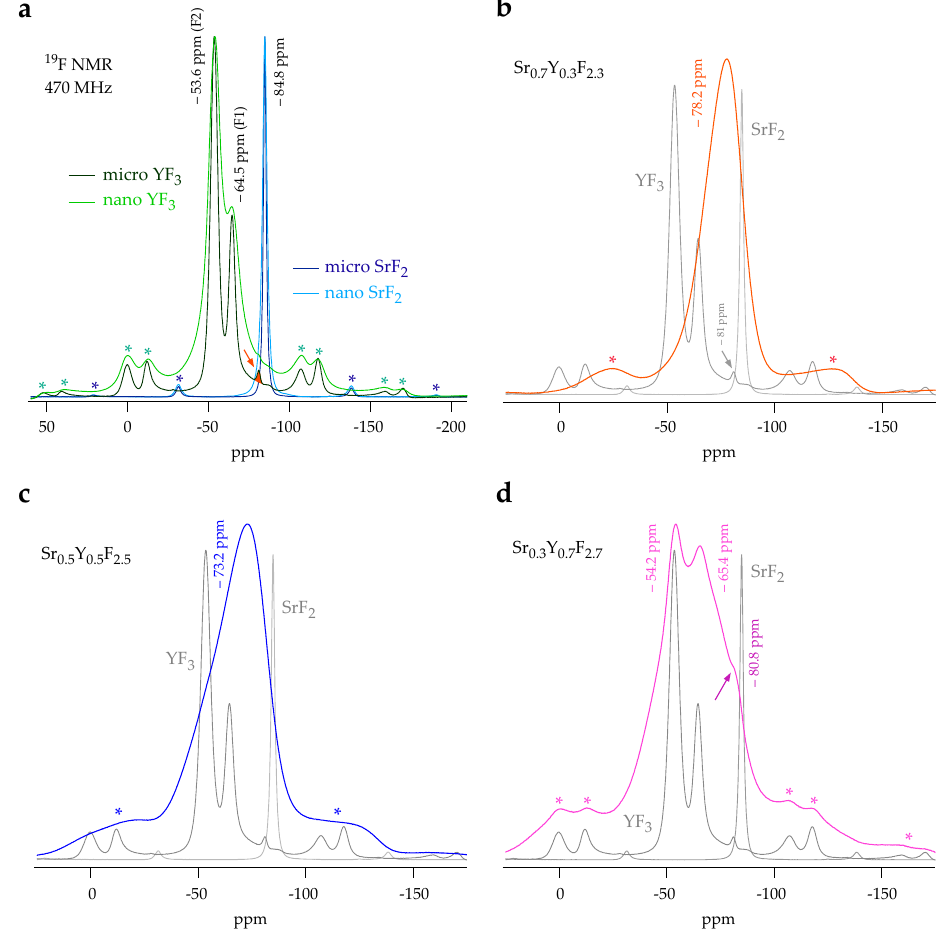
Figure 3. ( a – d ) 19 F magic angle spinning nuclear magnetic resonance (MAS NMR) spectra